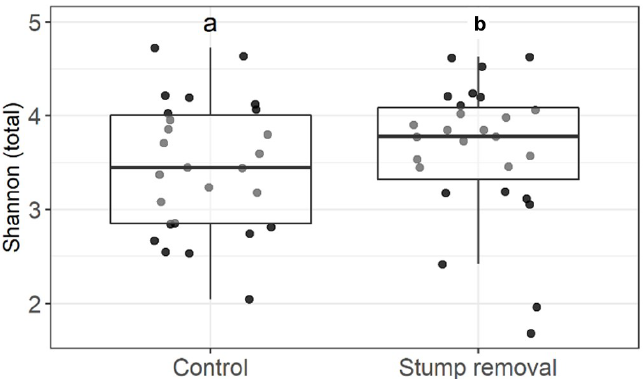
Figure 3. Effect of stump removal on the Shannon diversity of fungal OTUs. Middle lines,